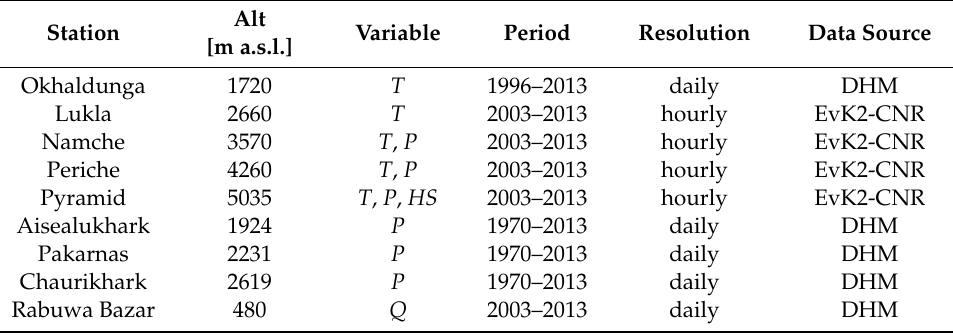
Table 1. Hydro-climate stations used in the study. DHM is the Nepal Department of Hydro-Meteorology. EvK2-CNR is EvK2-CNR committee of Bergamo, Italy. T is temperature, P precipitation, HS is snow depth, Q is stream